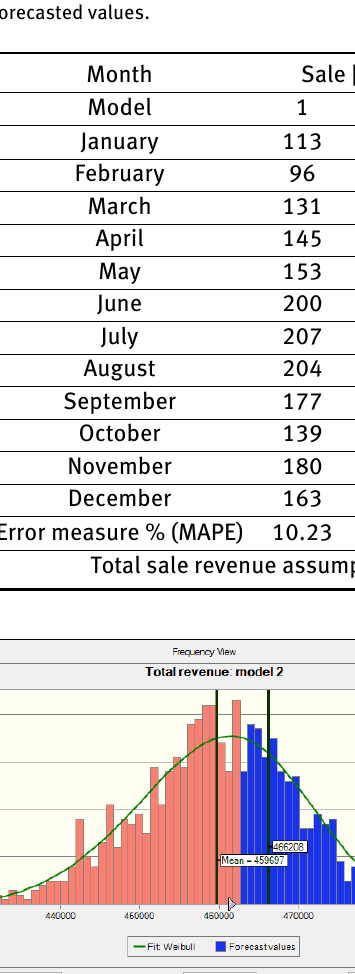
Table 4: Forecasted values.